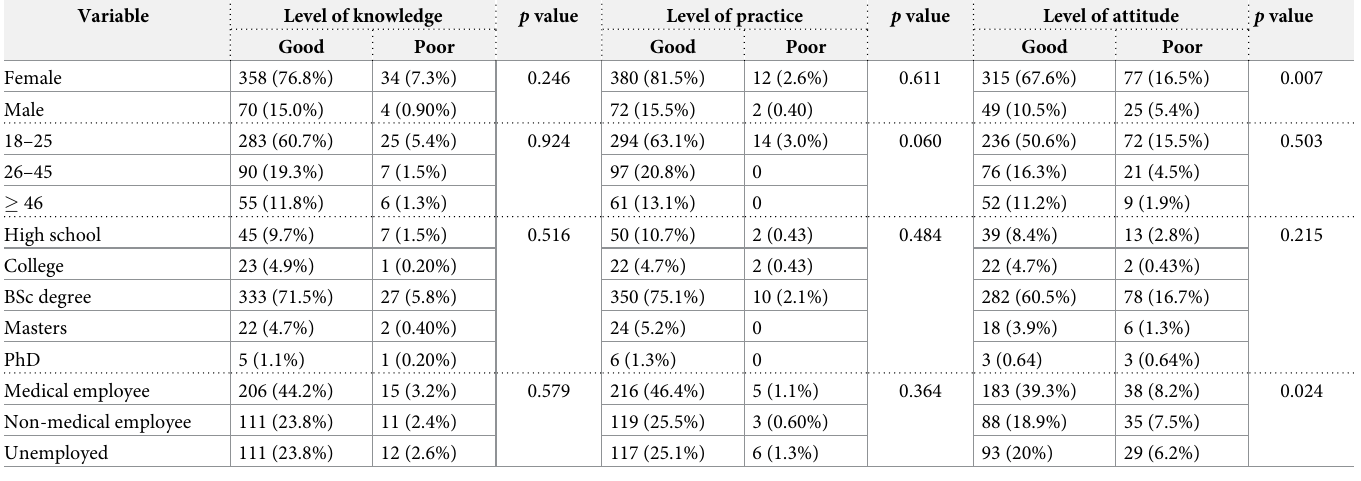
Table 7. Knowledge, practice and attitude level differences between group participants by demographic